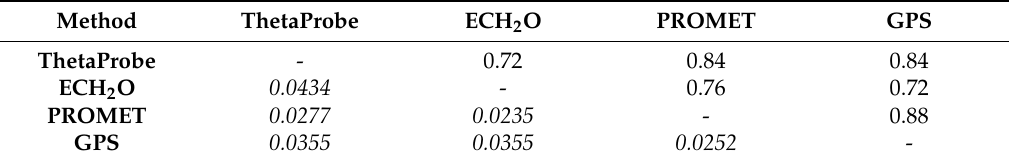
Table 4. Statistical overview of the correlation coefficient and the RMSE comparing ThetaProbe, ECH 2 O, PROMET and GPS. The upper triangular part (regular) represents the correlation coefficient and the lower triangular part ( italics ) represents the